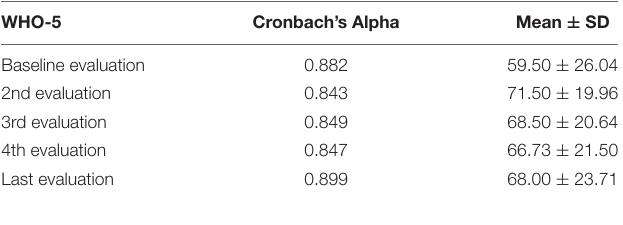
TABLE 2 | Cronbach’s alpha, mean, standard deviation of WHO-5 evaluations.